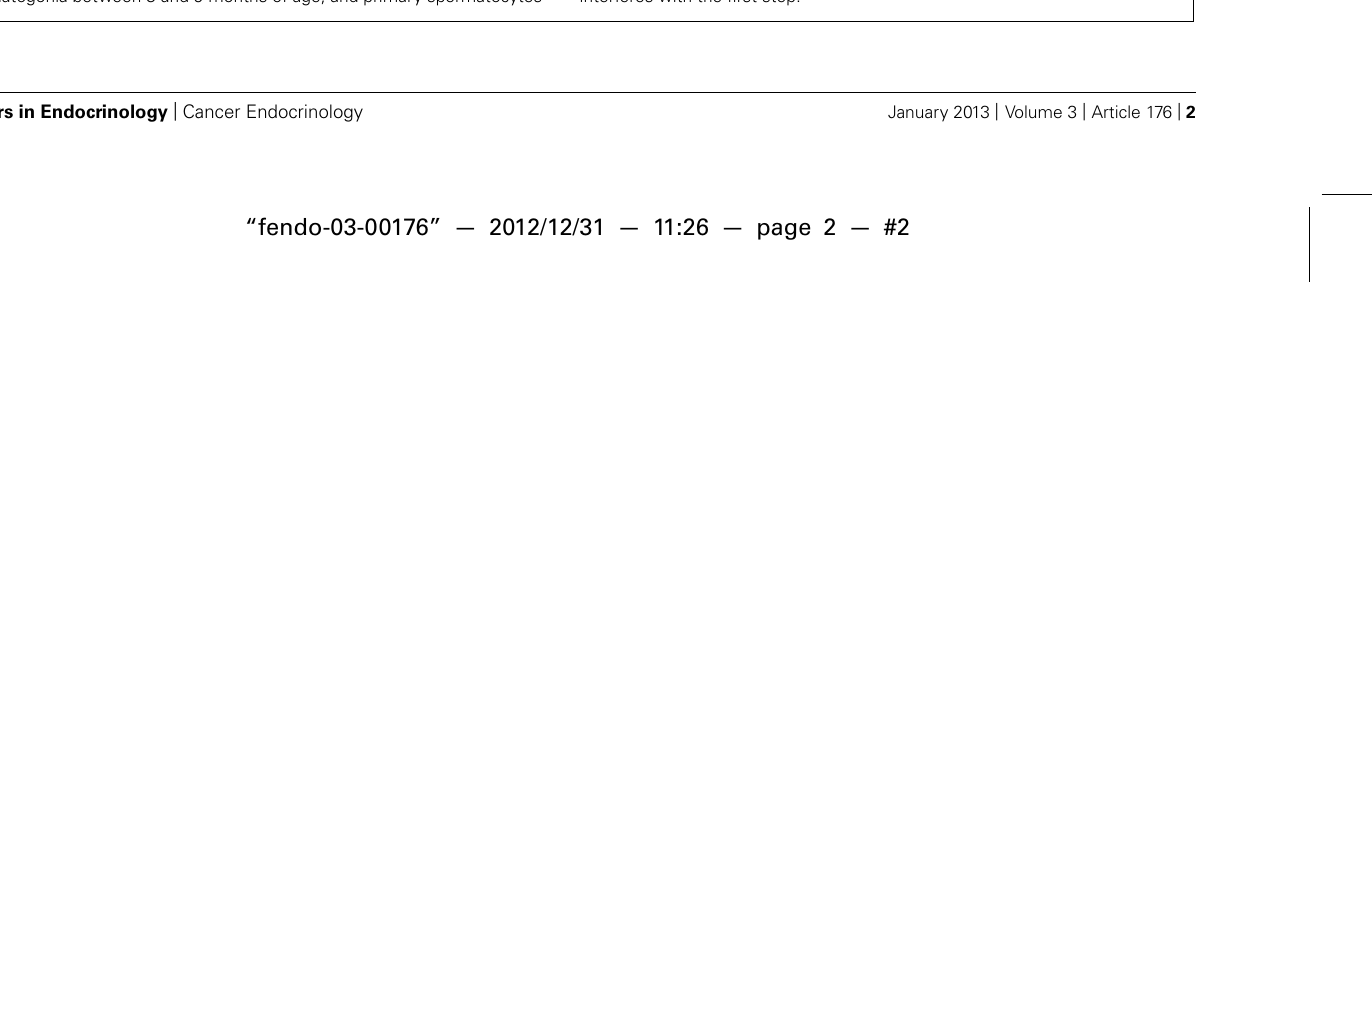
FIGURE 2 | “Mini-puberty,” with testosterone (T) and MIS/AMH secreted after birth. Neonatal gonocytes mature into adult dark spermatogonia between 3 and 9 months of age, and primary spermatocytes